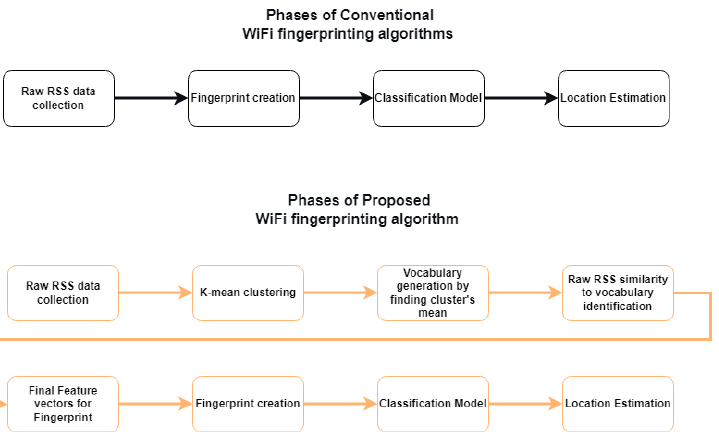
Figure 2. Flowchart of conventional fingerprinting-based IPS and proposed BoF-assisted